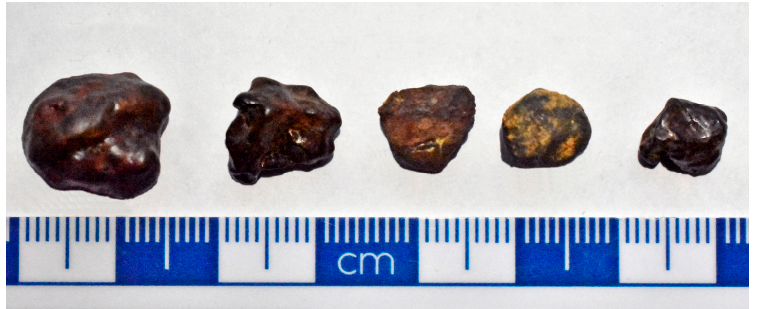
Figure 1. Examples of different size goethite pisoliths and nodules.